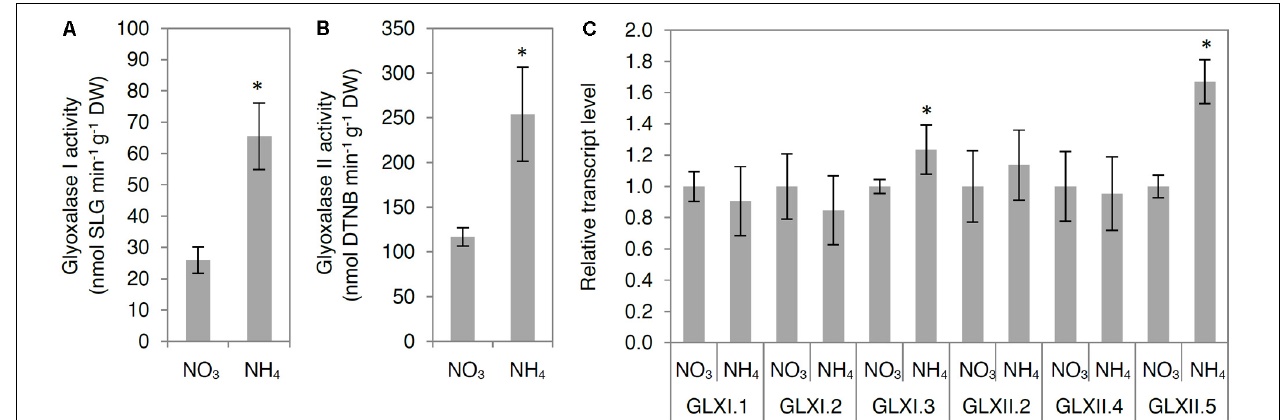
FIGURE 4 | Influence of ammonium (NH 4 + ) nutrition on principal methylglyoxal (MG) detoxification pathway. Activities of (A) glyoxalase I and (B) glyoxalase II; (C) expression of glyoxalase I and II genes in leaf tissue of nitrate (NO 3 − )-grown and NH 4 + -grown plants. Values are the mean ± standard deviation (SD) of 3–4 biological and 2 technical replicates. Significant differences ( P ≤ 0.05) between NO 3 − -grown and NH 4 + -grown plants are indicated by an asterisk ( ∗ ). DTNB, 5,5 (cid:48) -dithio-bis-2-nitrobenzoic